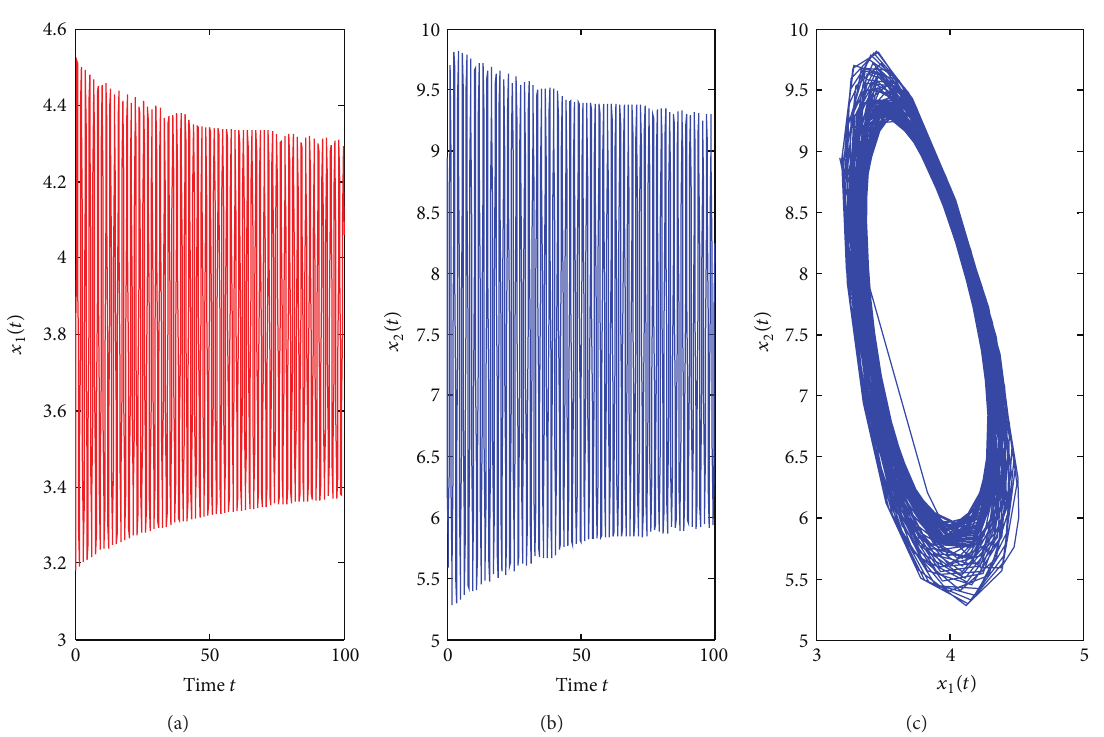
Figure 8: 𝐸 ∗ is unstable for 𝜏 1 = 0.360 > 𝜏 1∗ = 0.3490 at 𝜏 2 = 0.3